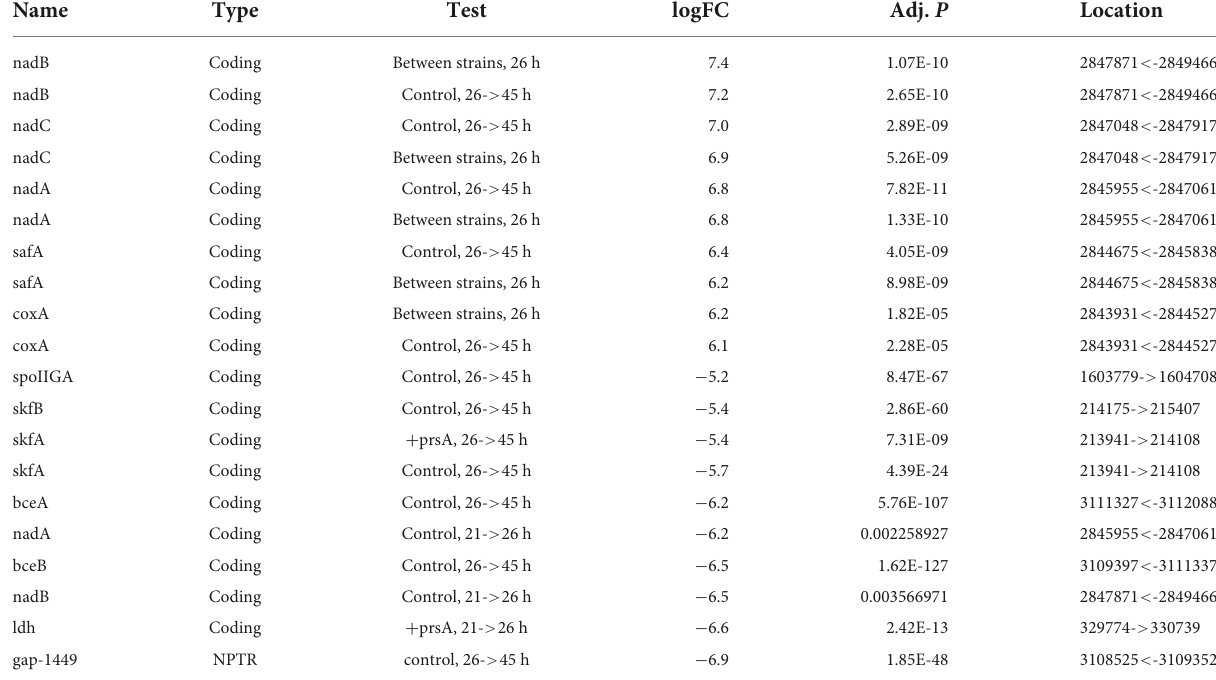
Thetableliststhetop10mostextremeupregulatedanddownregulatedgenomicelementsaccordingtotheirlogFCofdifferentialexpression(fourthcolumn).prsAisexcludedsinceitwas upregulated with an approximate logFC of 20 between strains at all-time points. For each genomic element, the locations (last column) are relative to the reference genome (see section “Materials and methods”). The pairwise tests (third column) refer to the conducted differential expression analysis ( Figure 1C ), and the corresponding adjusted P -values are listed in thefifthcolumn.